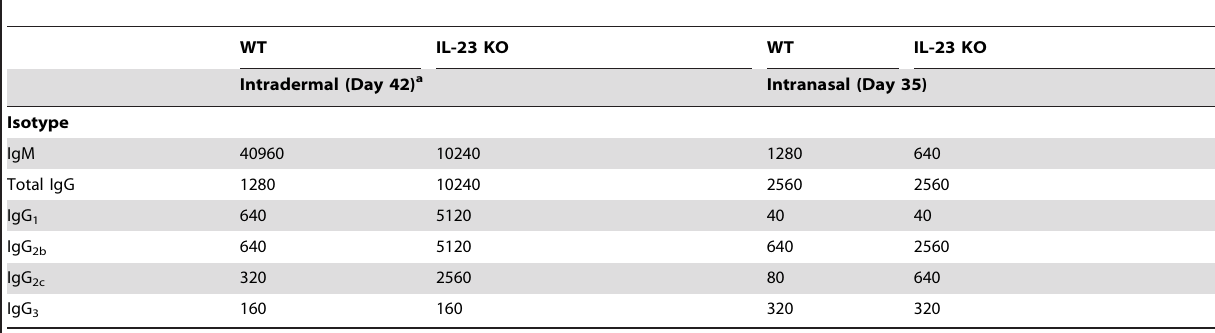
Table 1. Similar titers of serum antibodies titers in LVS-vaccinated WT and IL-23 KO mice.